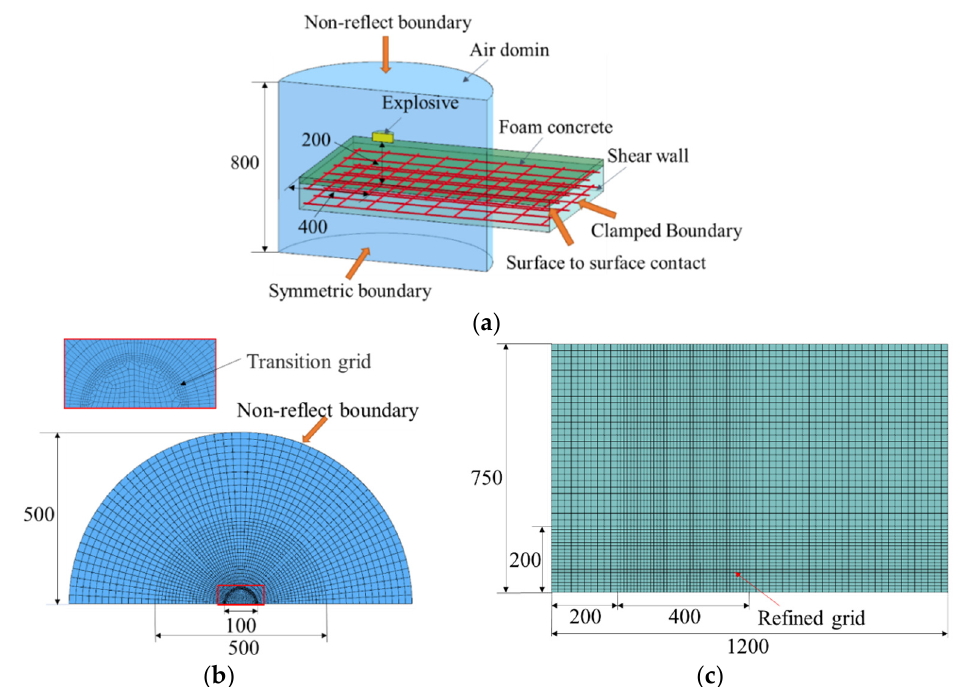
Figure 8. Model and grid meshing (unit: mm): ( a ) Finite element model; ( b ) Air domain grid; ( c ) RC wall grid.